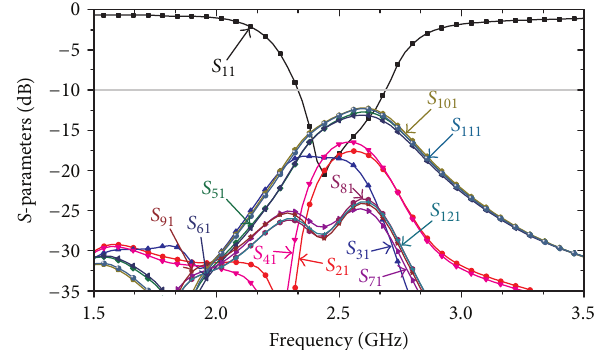
Figure 8: Simulated 𝑆 -parameters of 12-port antenna